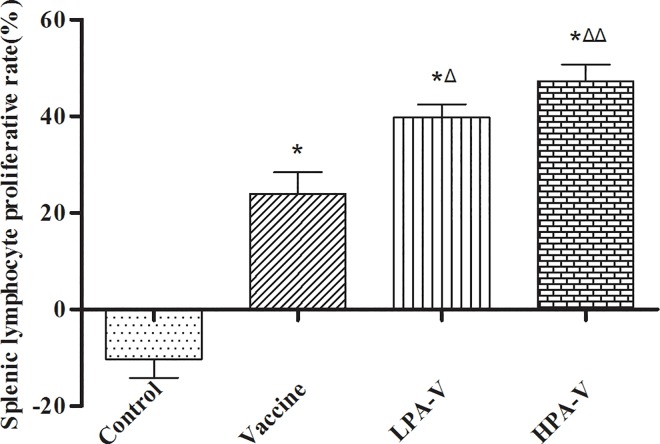
Splenic lymphocyte proliferative rates of the different groups after 72 h of culture under stimulation with three influenza virus antigens.The mice received intranasal administrations as described in Fig 1. The spleens were harvested on day 21, and splenic lymphocyte were cultured with a final concentration of 40 μg/mL of HA or without ITIV antigens. After 72 h, splenic lymphocyte proliferation was measured using the MTT assay. The splenic lymphocyte proliferative rate (%) was calculated according to the following formula: the splenic lymphocyte proliferative rate (%) = (the mean ODITIV treatment group—the mean ODcontrol group)/the mean ODcontrol group (n = 12). *P<0.001 vs. Control group; ΔP<0.05, ΔΔP<0.01 vs. Vaccine group.